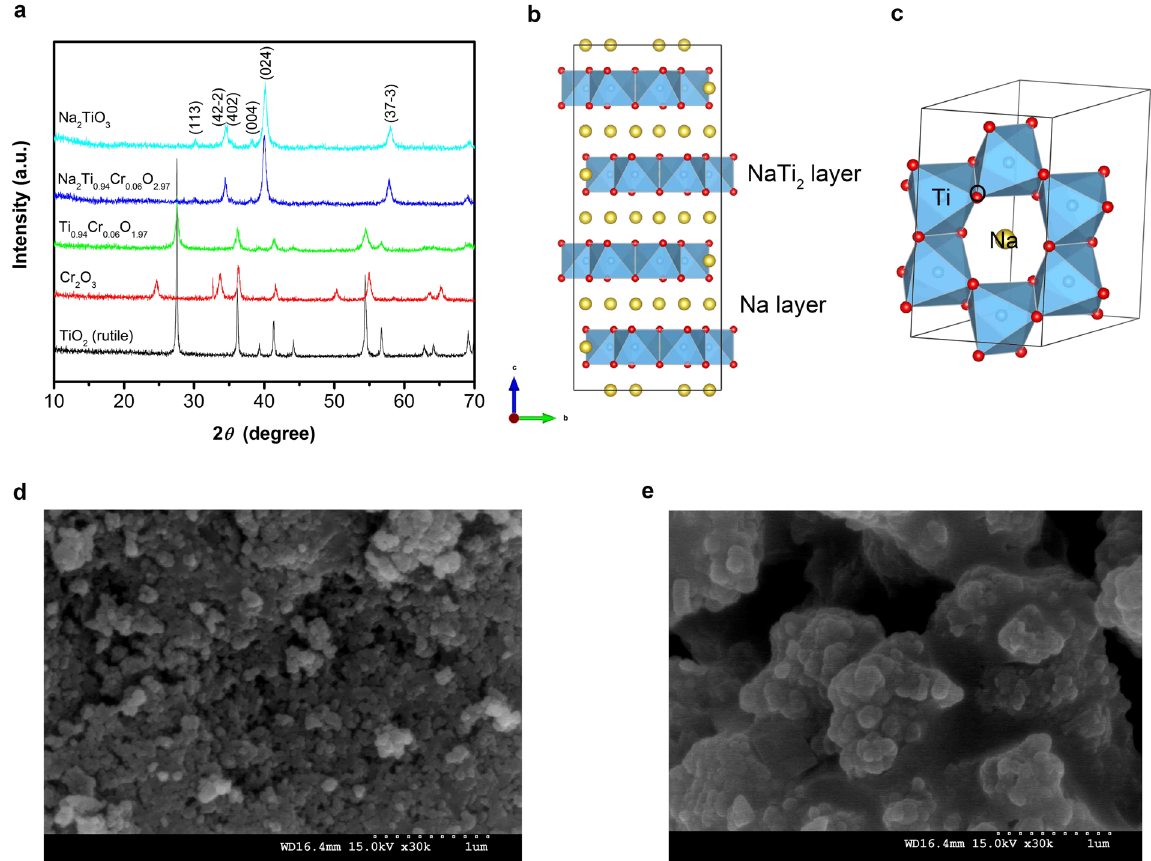
Figure 1. Material characterization of Na 2 TiO 3 and Na 2 Ti 0.94 Cr 0.06 O 2.97 synthesized at 500 °C for 6 h. ( a) XRD patterns for raw materials TiO 2 , Cr 2 O 3 , TiO 2 -Cr 2 O 3 solid solution, Na 2 TiO 3 and Na 2 Ti 0.94 Cr 0.06 O 2.97 . ( b) Crystal structure of Na 2 TiO 3 . ( c) Polyhedral drawing of Na 1/3 Ti 2/3 layers. SEM images of as-prepared Na 2 TiO 3 ( d ) and Na 2 Ti 0.94 Cr 0.06 O 2.97 ( e